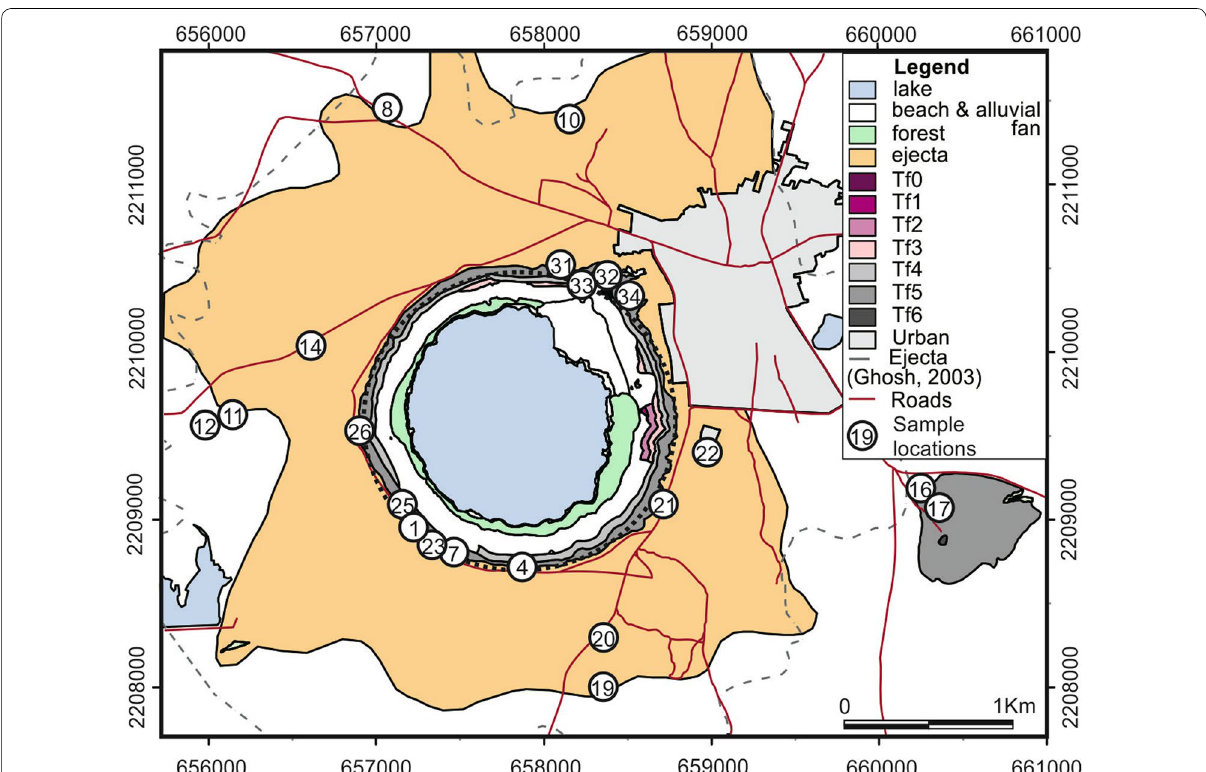
Fig. 1 Map of Lonar crater (after Maloof et al. 2010) with sampling sites of this study. Lava flows: Tf0, Tf1, Tf2, Tf3, Tf4, Tf5, and Tf6. Coordinates are represented in